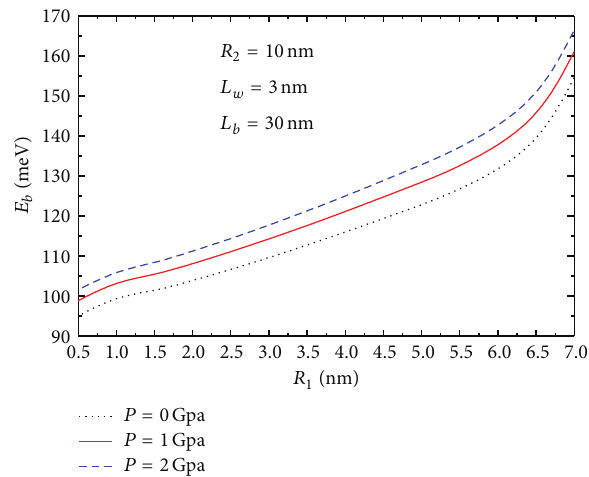
Figure 4: The ground-state donor binding energy in cylindrical wurtzite GaN/Al 𝑥 Ga 1−𝑥 N strained QR as a function of the QR inner radius ( 𝑅 1 ) for 𝑅 2 = 10 nm, 𝐿 𝑤 = 3 nm, 𝐿 𝑏 = 30 nm, and several values of the hydrostatic